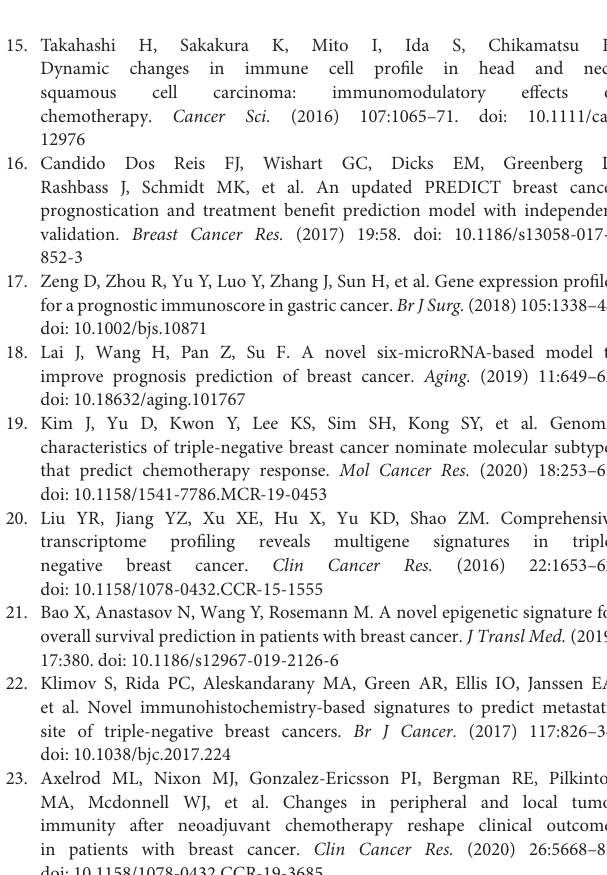
absolute value (a/b); (C) KM plot of lymphosum of T cell, B cell and NK cell (a/b); (D) KM plot of CD3 + CD8 + cytotoxic T cell percent (a/b); (E) KM plot of CD4+/CD8 + T cell ratio (a/b); (F) KM plot of CD3 + CD4 + helper T cell percent (a/b). Supplementary Figure 4 | Forest plot of index selected by Cox regression. Supplementary Table 1 | Relationship of peripherally immune status change before and after NAC and ER status at diagnosis. Supplementary Table 2 | Relationship of peripherally immune status change before and after NAC and PR status at diagnosis. Supplementary Table 3 | Relationship of peripherally immune status change before and after NAC and HER2 status at